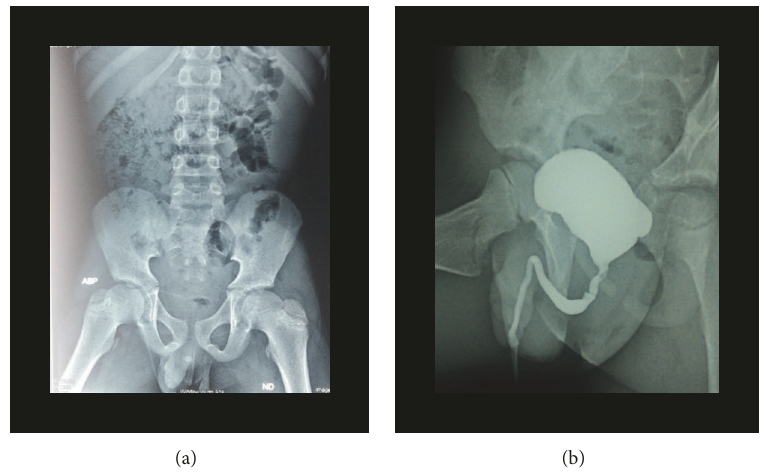
Figure 9: (a) Scout film, stone in the penile midshaft (case 2). (b) VCUG, partial urethral obstruction (case 2).